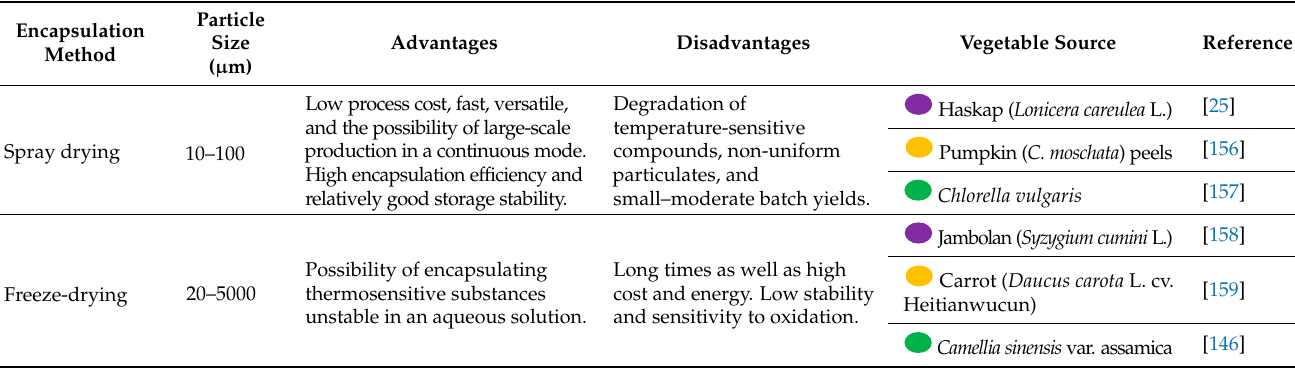
Table 5. Advantages and disadvantages of some encapsulation methods and applications in different natural matrices rich in anthocyanins, carotenoids, and